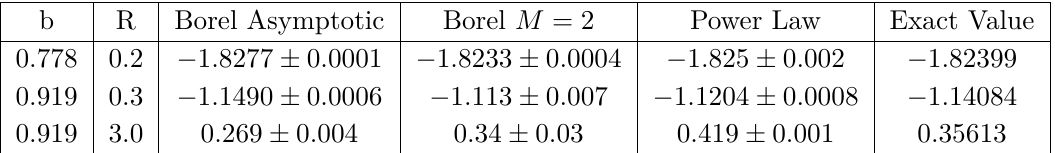
Table 1. Fits including an uncertainty analysis. All data is for µ ShG = 0 . 1